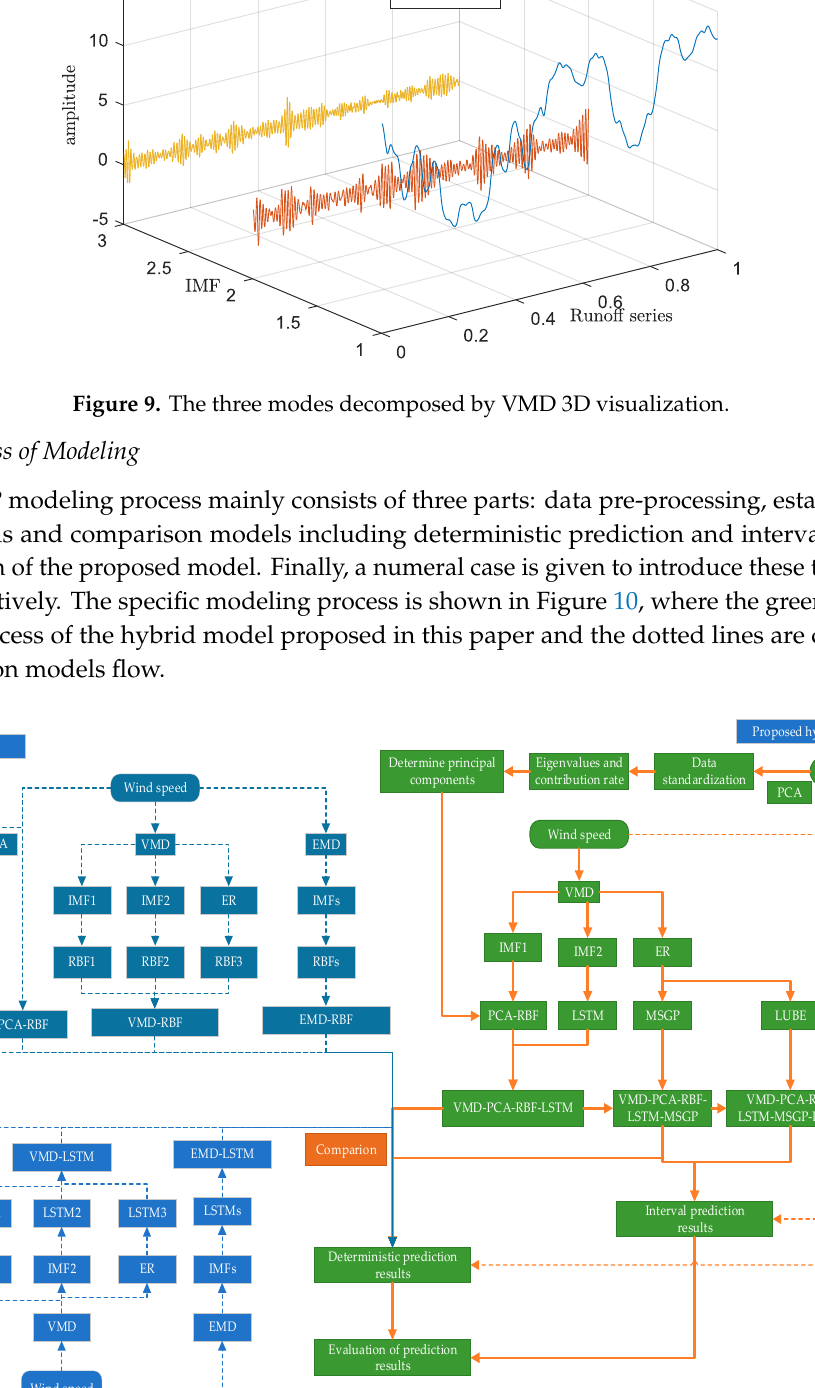
Figure 8. The decomposed results of wind speed. ( a ) The decomposed results of wind speed by VMD; ( b ) the decomposed results of wind speed by EMD.